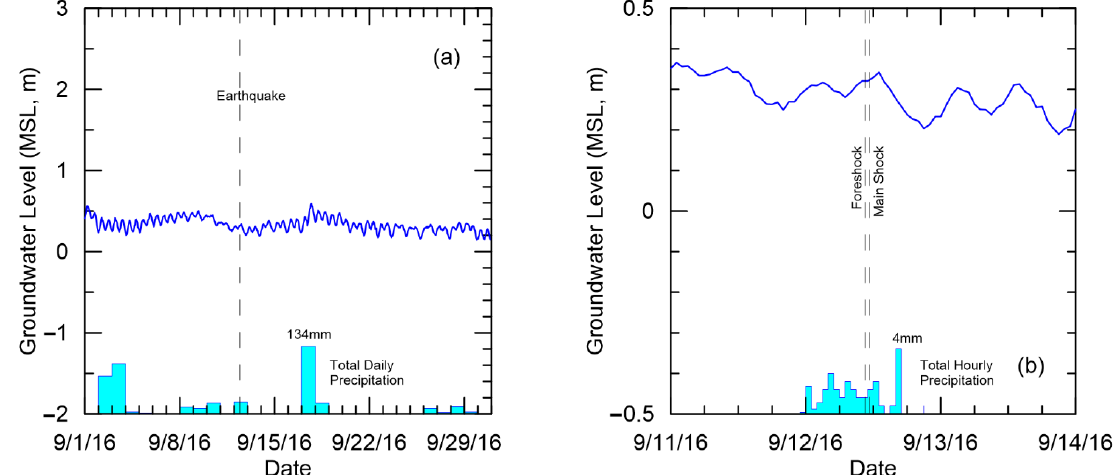
Figure 10. Groundwater level changes for well W5 during ( a ) September 2016 and ( b ) a closer inspection of the 3 days around the earthquake event.